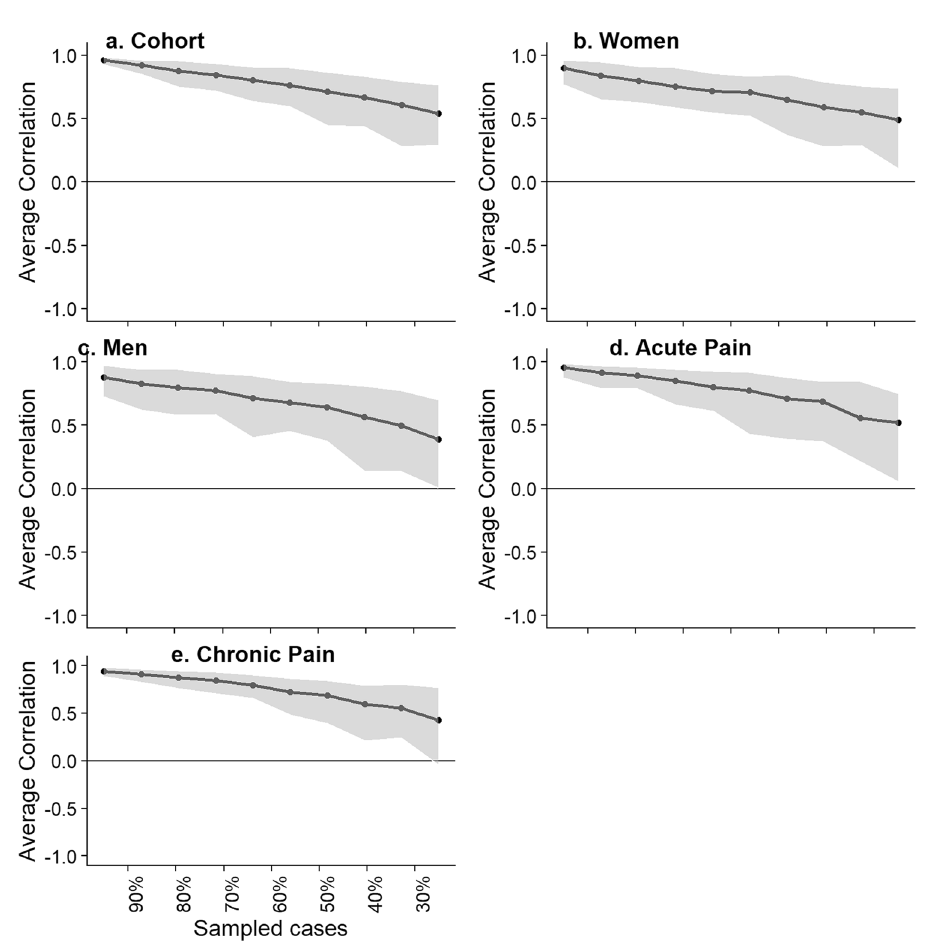
Figure 7. Average correlations between centrality indices. Average correlations between centrality indices of networks sampled with persons dropped and networks built on the entire input dataset, at all follow-up time points. Lines indicate the means and areas indicate the range from the 2.5th quantile to the 97.5th